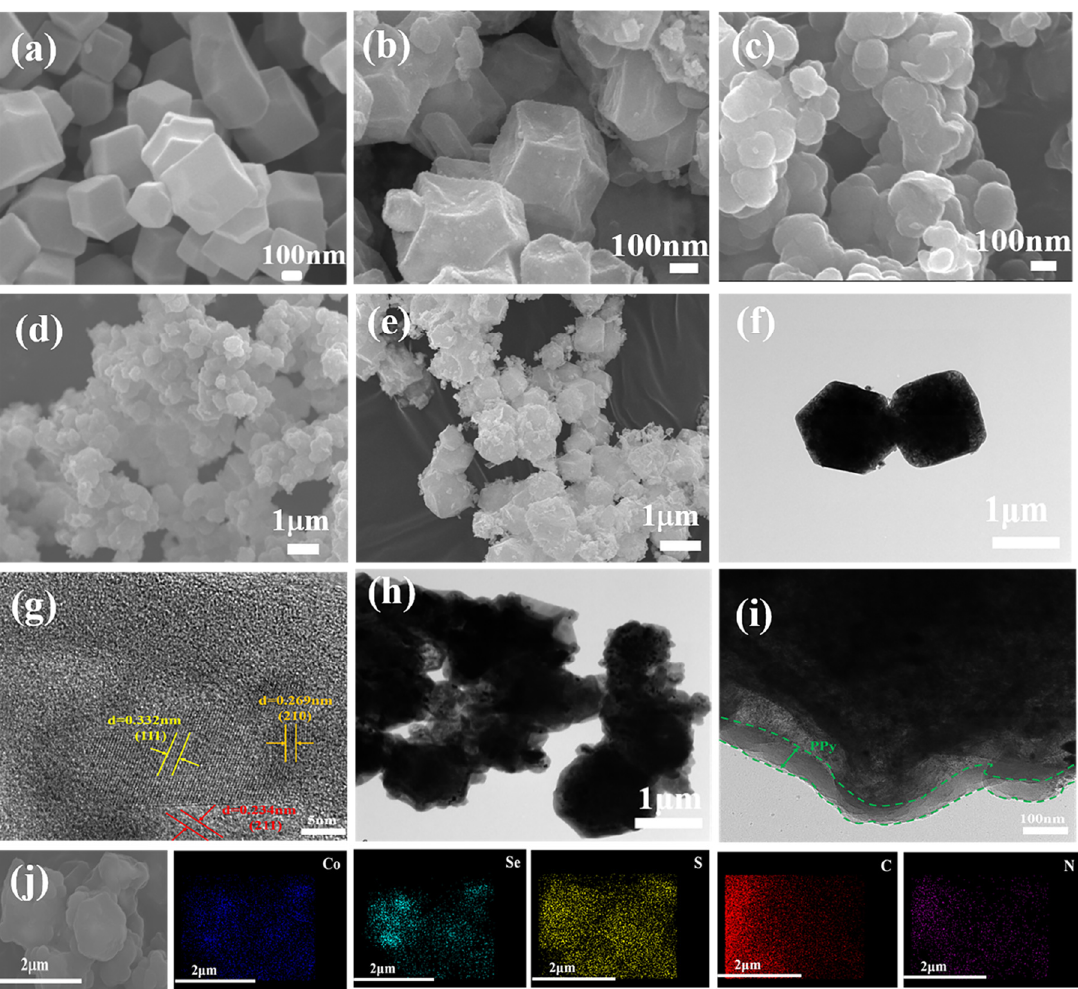
Figure 4. SEM images of ( a ) ZIF/67, ( b ) CoSe 2 , ( c ) CoSe 2 @PPy, ( d ) CoSe 2 -S, ( e ) CoSe 2 @PPy-S, HR- TEM images of ( f , g ) CoSe 2 , ( h , i ) CoSe 2 @PPy, and ( j ) elemental mapping results of Co, Se, C, N and S in CoSe 2 @PPy-S composites.